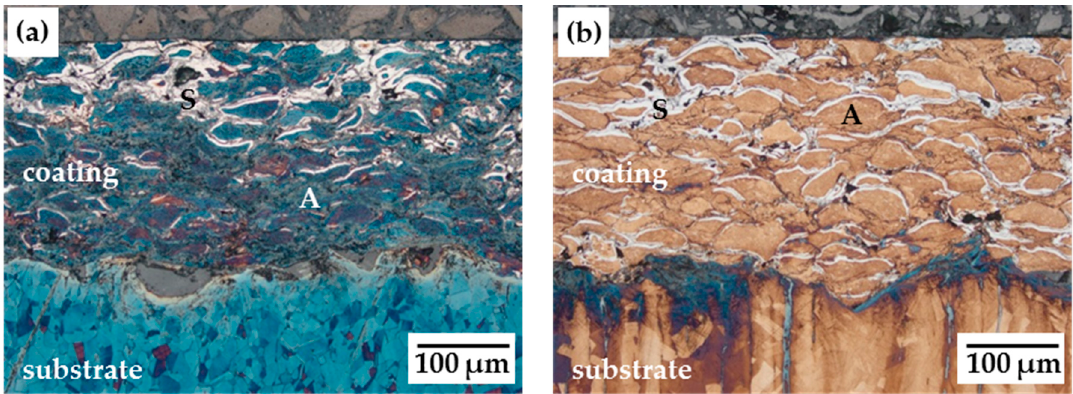
Figure 1. Cross-sectional micrographs of AISI 316L HVOF coating after gas nitriding at ( a ) 420 ◦ C / 10 h and ( b ) 420 ◦ C / 10 h PM. (S: S-phase, A: austenitic phase).